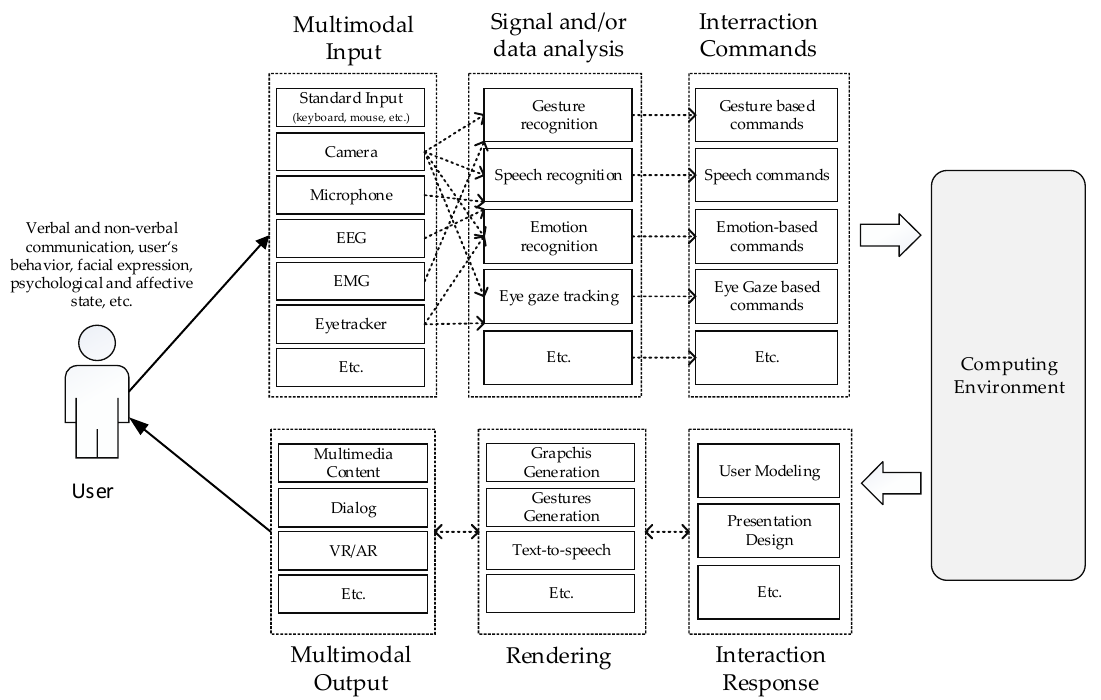
Figure 1. A general architecture of a multimodal HCII system (adapted from [6]).